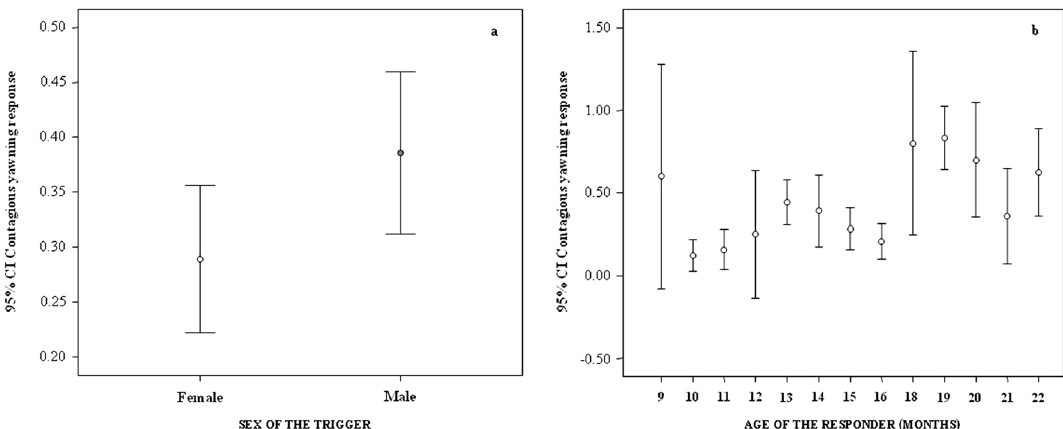
Figure 6. Error bars (mean, 95% confidence interval) showing the occurrence of yawn contagion (Y axis) as a function of individual factors (X axis): sex of the trigger ( a ) and age of the responder ( b ). Both variables have a significant main effect on yawn contagion (results of Model 2 included in Table 2) with ( a ) yawn contagion being highest when the trigger was a male and ( b ) linearly increasing with age (bivariate correlation via randomization: n = 13, r = 0.600, p = 0.031). CI confidence